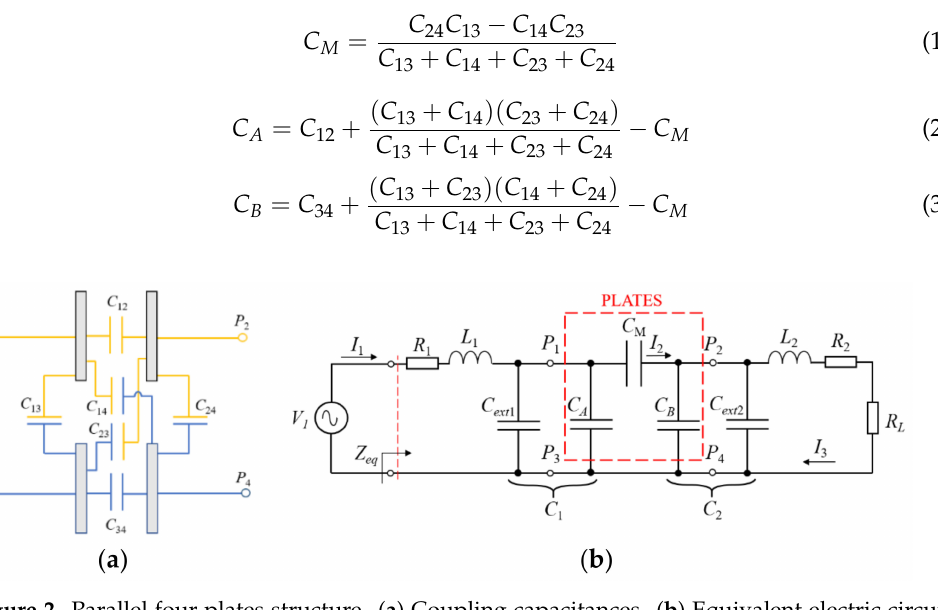
Figure 2. Parallel four plates structure. ( a ) Coupling capacitances. ( b ) Equivalent electric circuit of